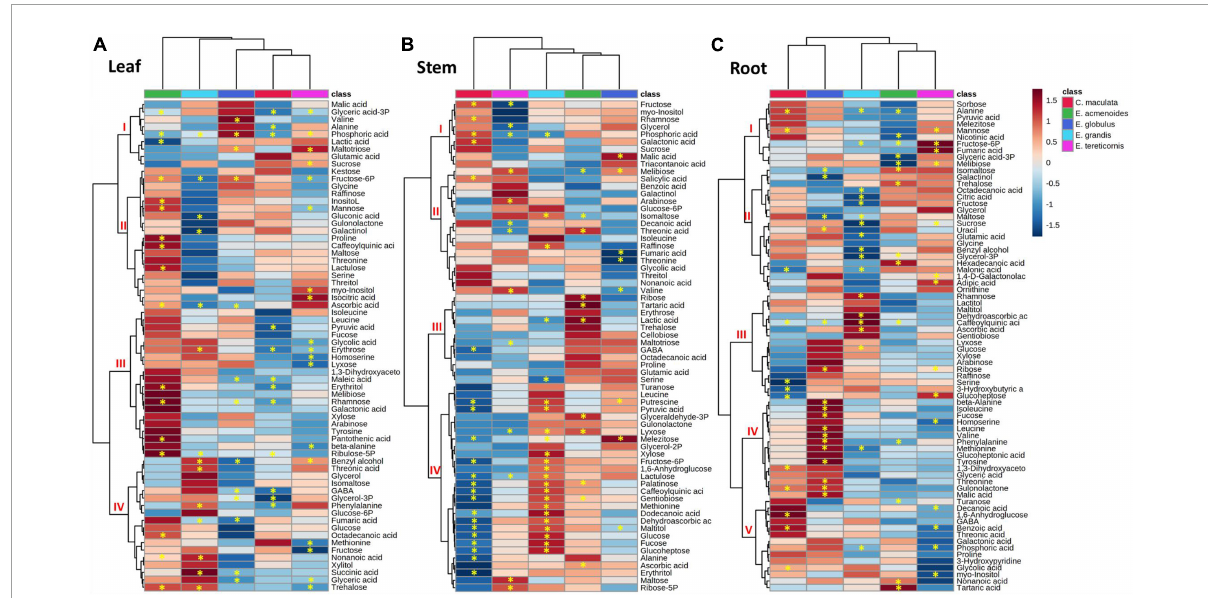
FIGURE4 Hierarchical cluster analysis of changes in primary metabolite levels of five eucalypt species cultivated in soil with low (Low P) and sufficient (Suf P) availability of phosphorus. Heat map representing the changes of log2 ratios (Low P/Suf P) metabolic contents in leaf (A) , stem (B) , and root (C) individually. Regions of blue or red indicate the metabolite level was decreased or increased, respectively. The clusters were generated in MetaboAnalyst using squared Euclidean distance and complete linkage. Asterisks indicate statistically significant differences ( P < 0.05) by Student’s t -test between P